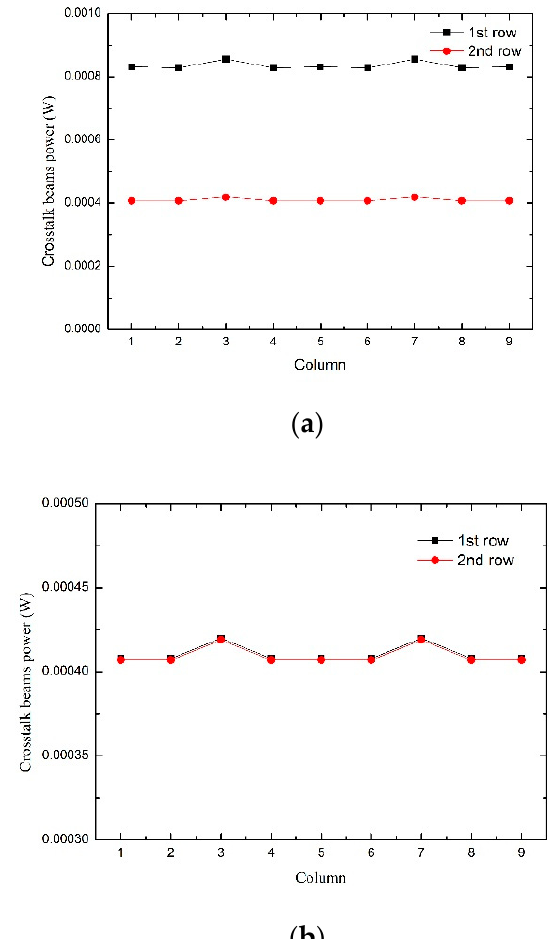
Figure 11. Diagram with crosstalk power values of the two rows. ( a ) Y axis, δ = − 2°, θ = 0°, ( b ) Y axis, δ = − 2°, θ = 0.5°.